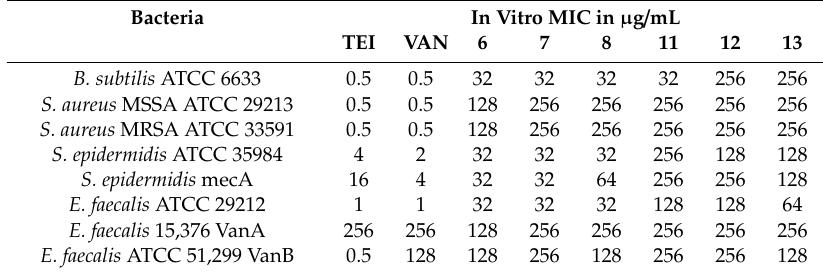
Table 1. Antibacterial evaluation of the new vancomycin aglycone hexapeptide derivatives.